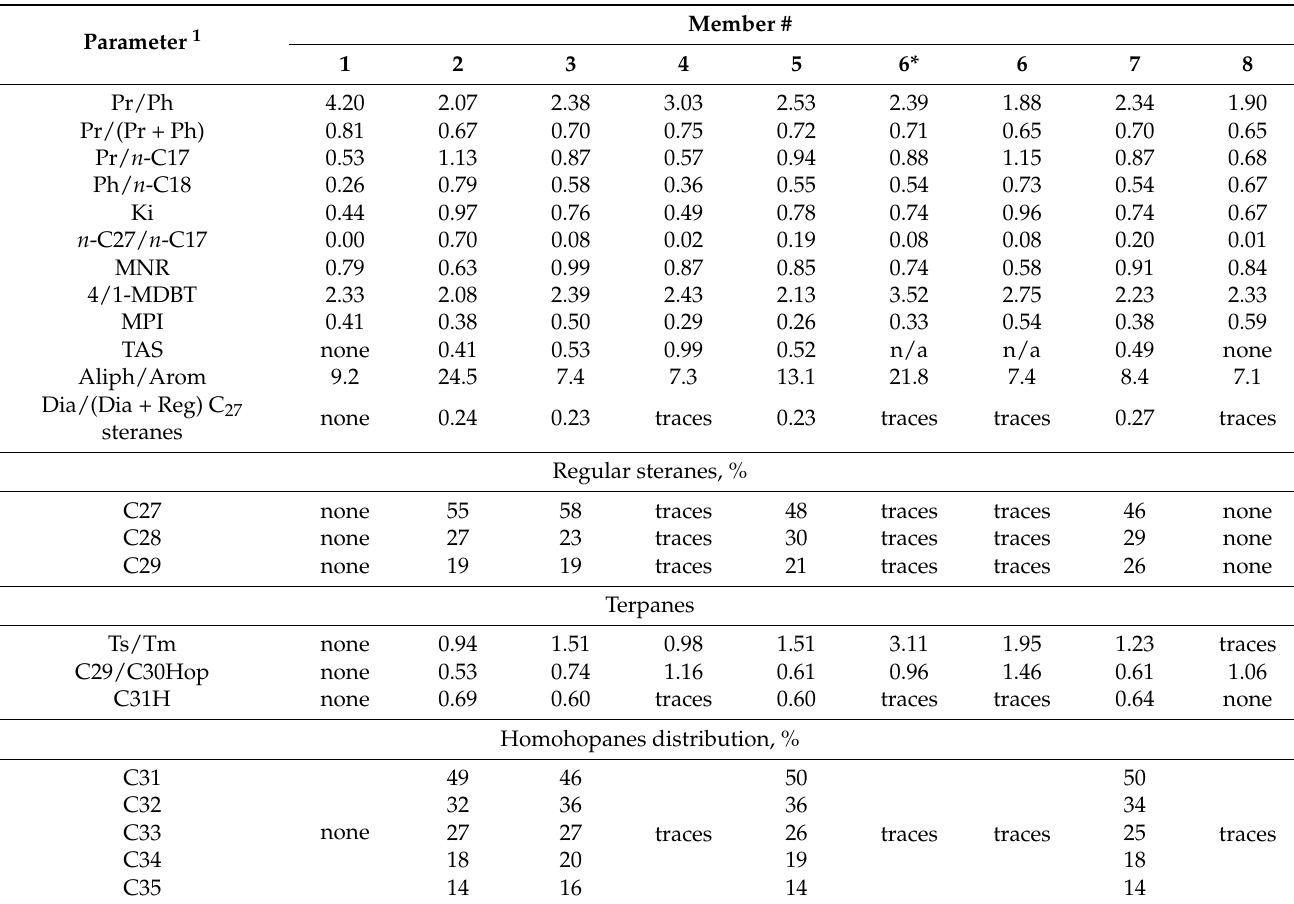
Table 4. Selected molecular and biomarker parameters of thermal